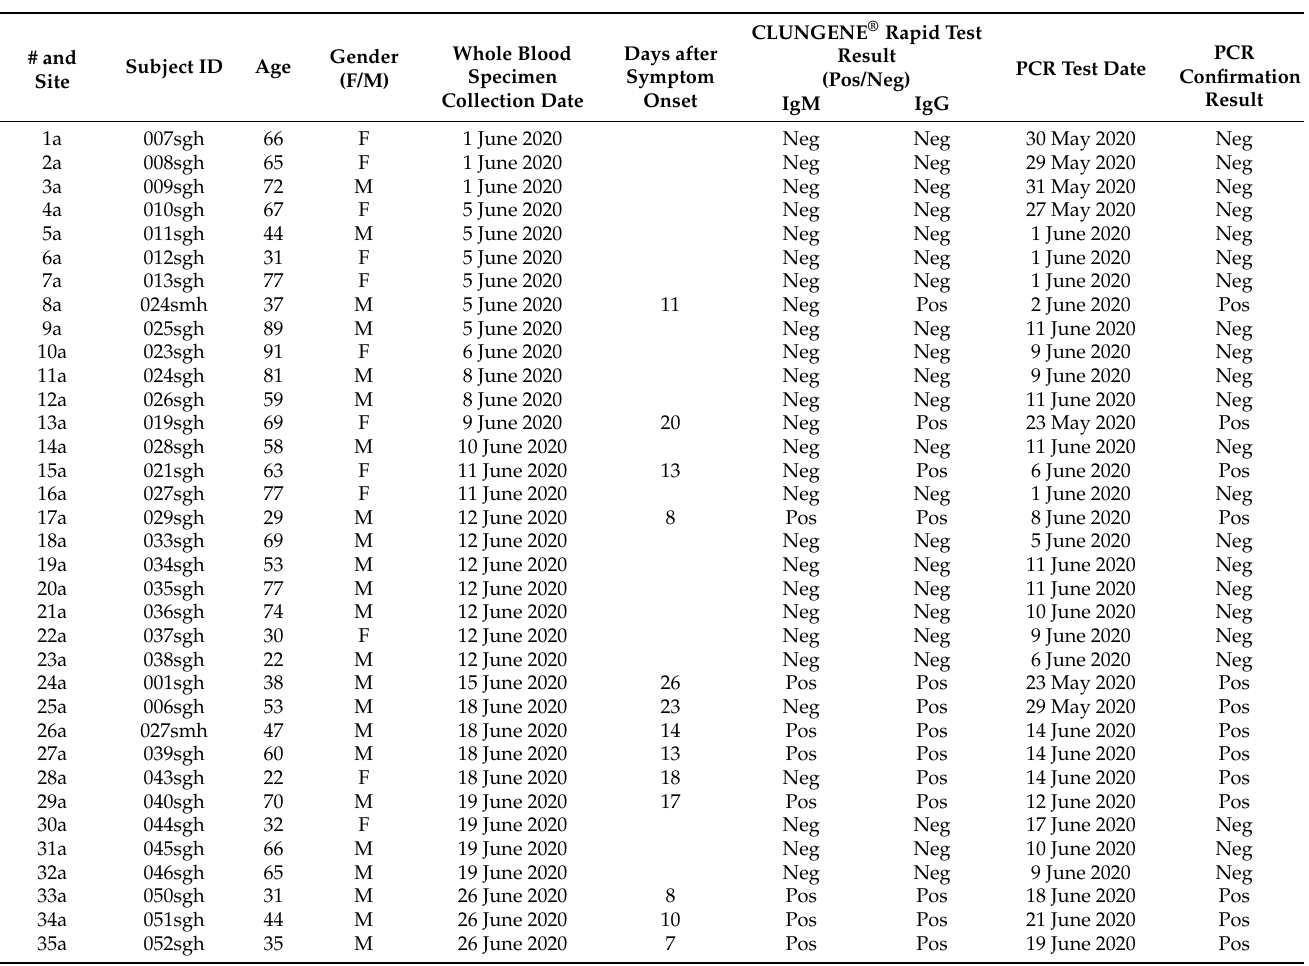
Table 5. Line Table